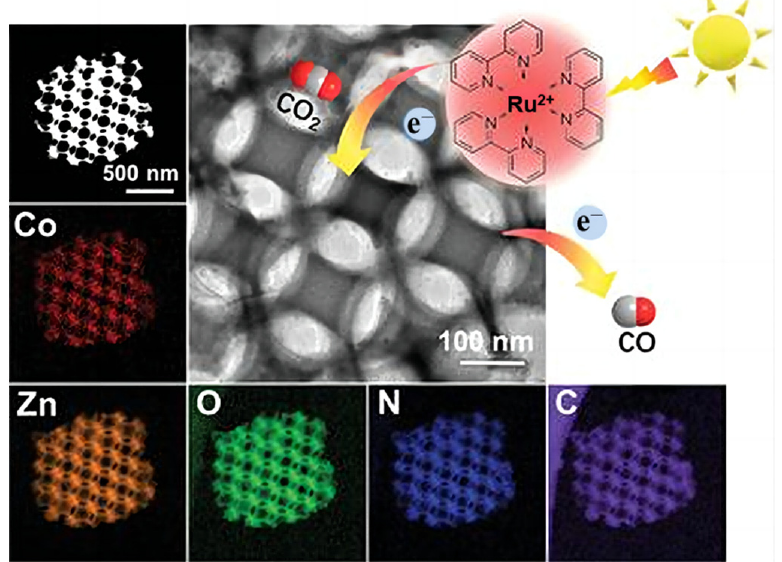
Figure 13. HAADF-STEM image of CoO x /N-C-ZnO and related elemental mapping images [99].